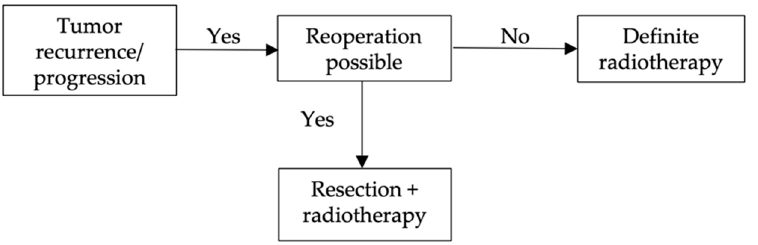
Figure 5. Treatment strategies after tumor recurrence/progression: Reoperation is the most used treatment option for tumor progression. However, in almost no case report, a second follow–up after the first recurrence is recorded, so no further evaluation can be made here as to how successful the respective therapy options are. These are only the therapies that are most frequently used.